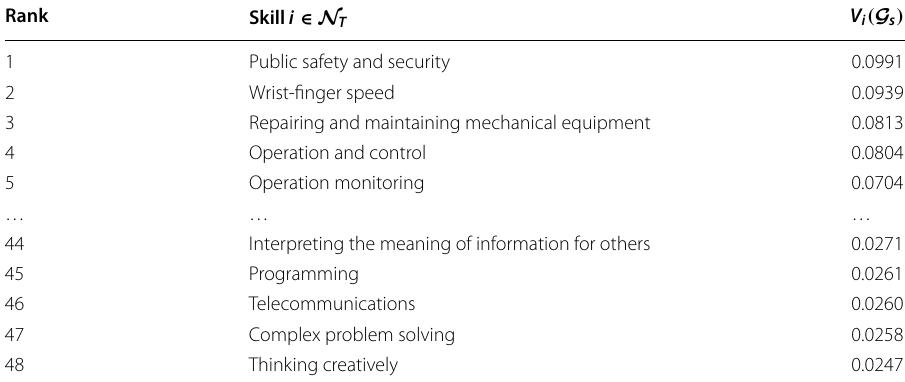
Table 6 Skill transition potentials from waiters and waitresses S to computer user support specialists